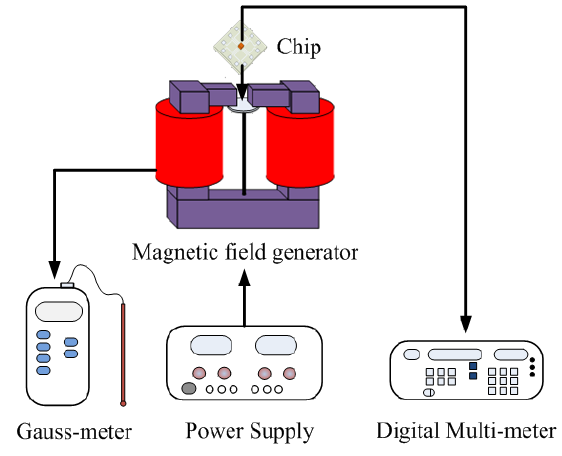
Figure 10. Measurement set-up for the magnetic sensor.